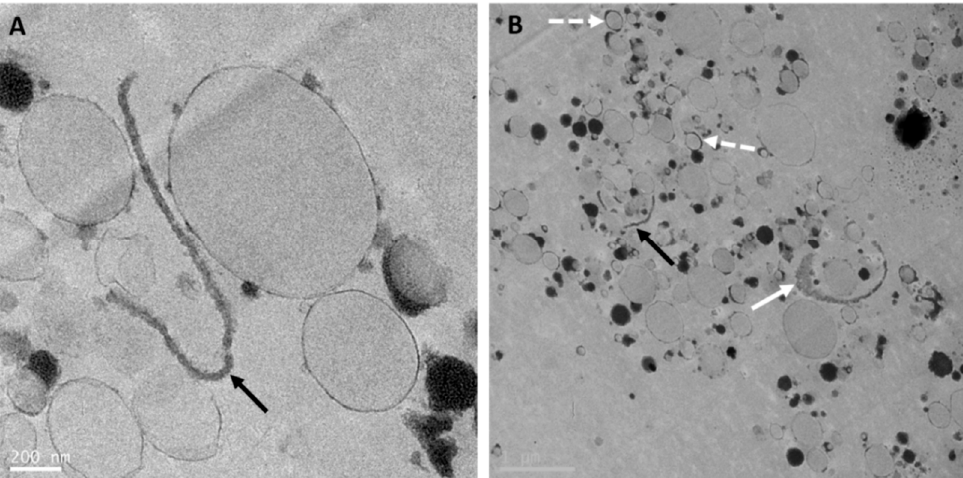
Figure 3. Transmission electron microscopy images ( A and B ) of reconstituted whole goat milk-based infant formula (Dairy Goat Co-operative, Hamilton, New Zealand) processed using the same method as in Gallier et al. [5]. Black arrows point at MFGM fragments in the serum phase ( A and B ). Full white arrow points at an MFGM fragment with attached cytoplasmic crescent filled with electron-dense material ( B ). Dashed white arrows point at droplets with thicker interface ( B ). Scale bars = 200 nm ( A ) and 1 µ m ( B